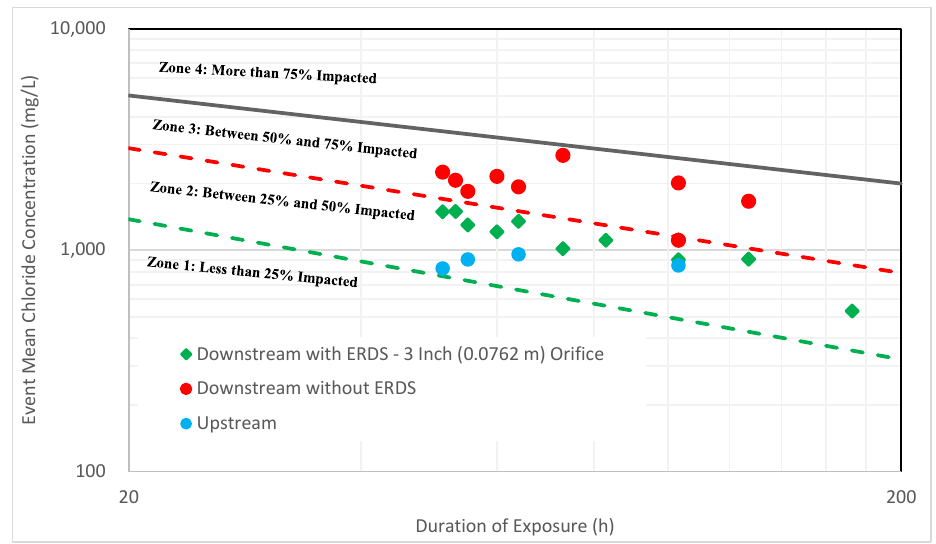
Figure 11. Event mean chloride concentration in the Credit River upstream and downstream of the Highways 407 and 401 with and without the ERDS.